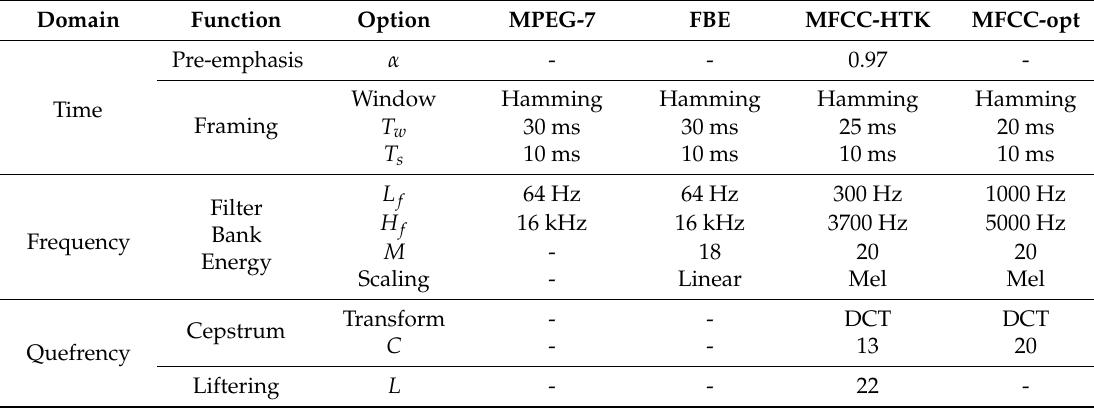
Table 5. Options for the extraction of features of a